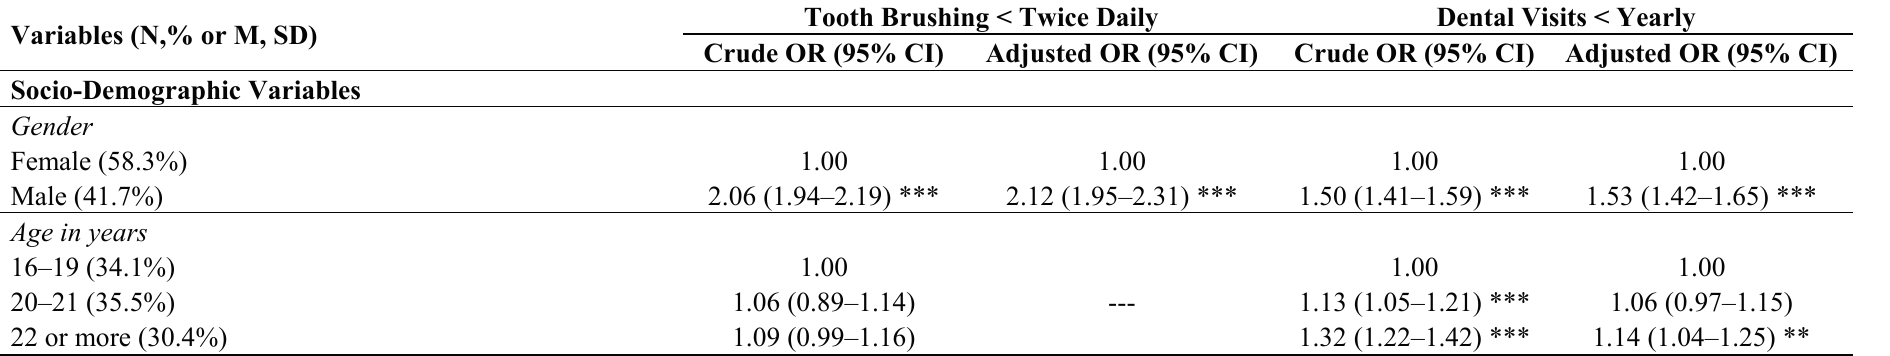
Table 2. Logistic regression analyses predicting oral health (tooth brushing and dental